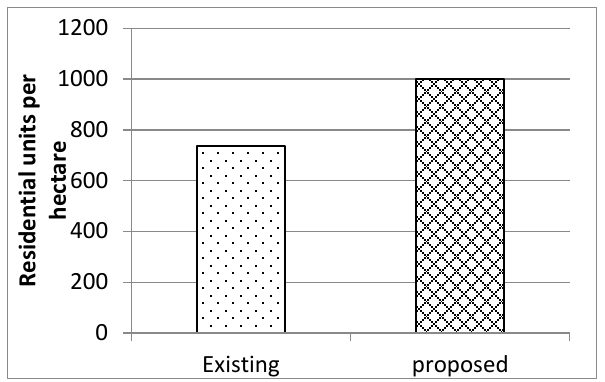
Figure 5. Comparison of the density of residential units per